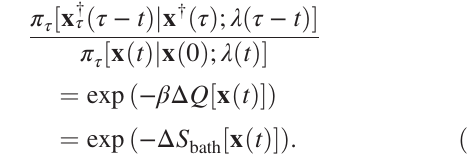
x Þ d x over i ð